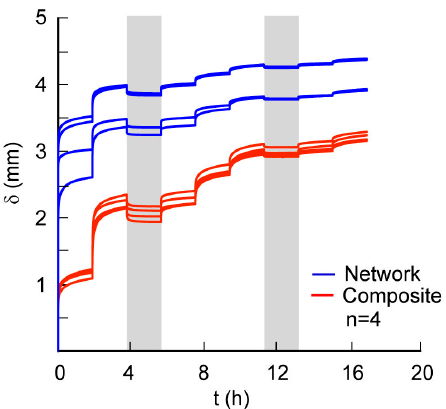
Figure 3. Changes in the specimen displacement during creep loading were obtained using an incremental loading sequence for network and composite scaffolds (grey columns highlighting the unloading steps).